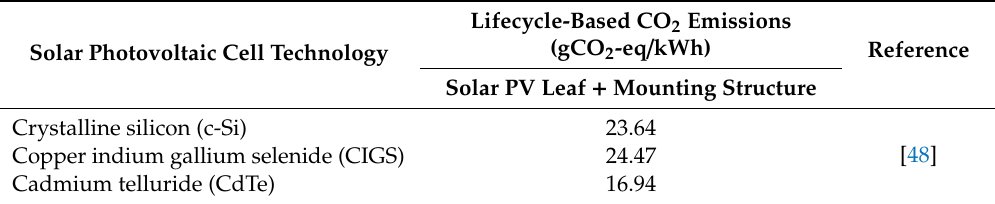
Table 10. Lifecycle greenhouse gas emissions for the chosen solar cell technologies as a photovoltaic leaf for the solar photovoltaic tree.